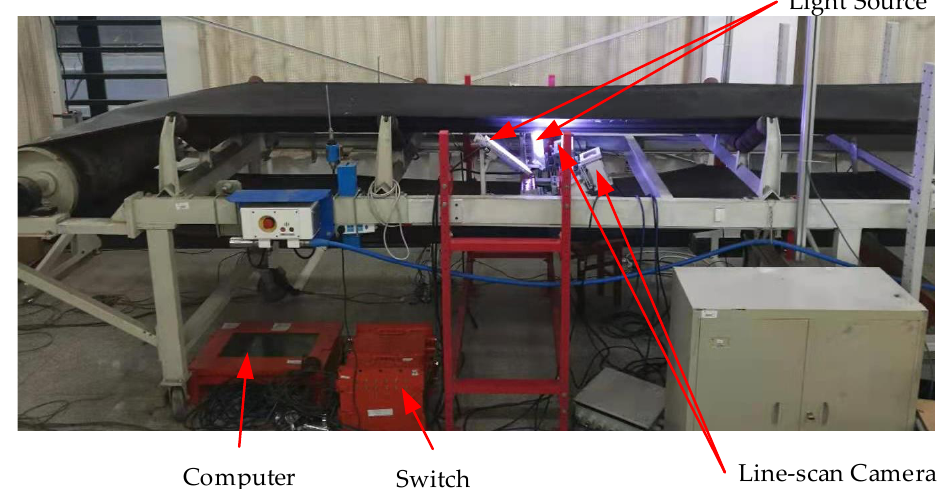
Figure 12. Experimental platform.